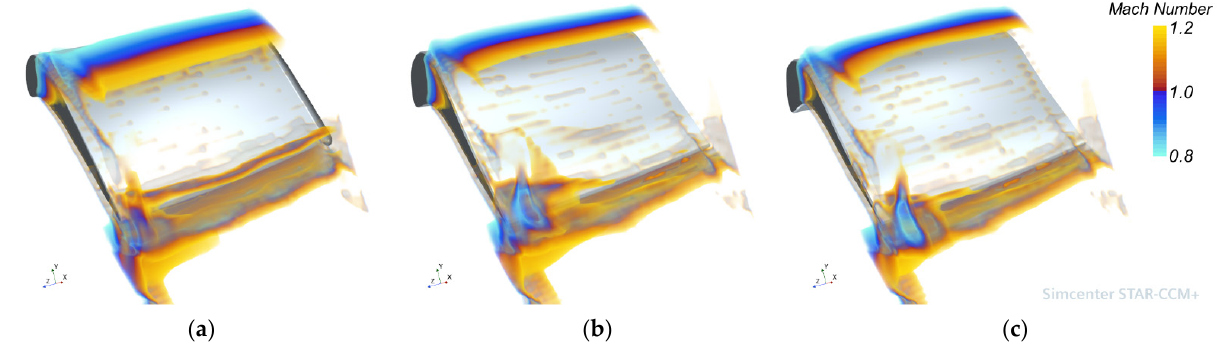
Figure 15. Mach number rendering: ( a ) Baseline design; ( b ) Design A; and ( c ) Design B. A further comparison is made by plotting the streamlines in the tip leakage regions and showing pressure coefficients on spanwise cross-sections in Figure 16. It appears the two optimized designs feature slightly more chaotic Mach number distributions in the local region near the trailing edge and tip leakage. The leakage flow’s influence on the overall performance is relatively small in comparison to the previously discussed suction- side effects. It can be observed that the streamlines in the high-efficiency design (Design A) are slightly more curved, yet the induced low-pressure spots by the secondary flow effects of the tip leakage flows are weak and about the same magnitude. Overall, the difference caused by the tip leakage flow is small in these three designs. The performance improvements in the optimized designs are more influenced by other flow effects discussed earlier, such as the increased minimum pressure on the suction side near the trailing edge (Figures 11–13), and the reduction of the shock structure (Figure 15).